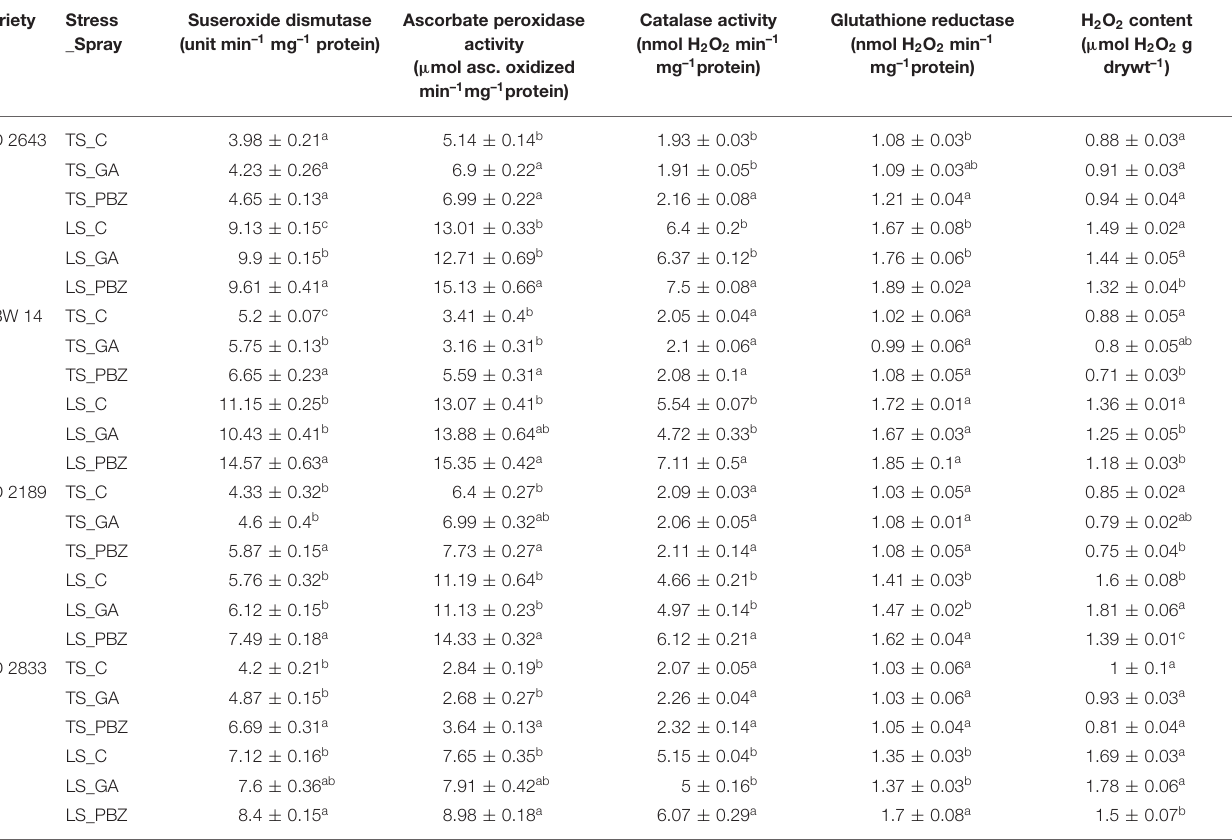
TABLE 3 | Effect of post-anthesis application of gibberellic acid (100 ppm) and paclobutrazol (50 ppm) on superoxide dismutase content (unit min − 1 mg − 1 protein); glutathione reductase ( 1 A 412 min − 1 mg − 1 protein); ascorbate peroxidase ( µ mol ascorbate oxidized min − 1 mg − 1 protein); catalase activity (nmol H 2 O 2 min − 1 mg −